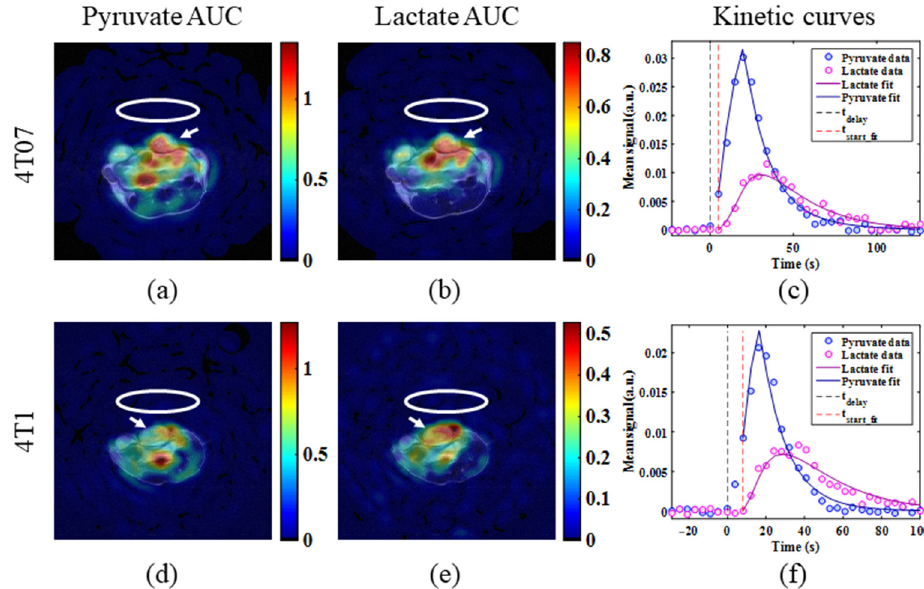
Figure 2. Representative hyperpolarized ( a , d ) [1- 13 C]pyruvate and ( b , e ) [1- 13 C]lactate AUC images (color) overlaid on T 2 -weighted anatomical reference images (grayscale) for mice bearing ( a , b ) metastatic dormant 4T07 tumors and ( d , e ) more aggressive, metastatic 4T1 tumors. The approximate 13 C surface coil location and targeted tumor for imaging are indicated by white ovals and white arrows, respectively. The corresponding pyruvate and lactate metabolite time courses from the targeted imaging tumor are displayed for the ( c ) 4T07 and ( f ) 4T1 breast cancer models along with the fitted curves. The time of hyperpolarized [1- 13 C]pyruvate injection is indicated by t delay and the first time point used for kinetic modeling is labeled with t start_fit .